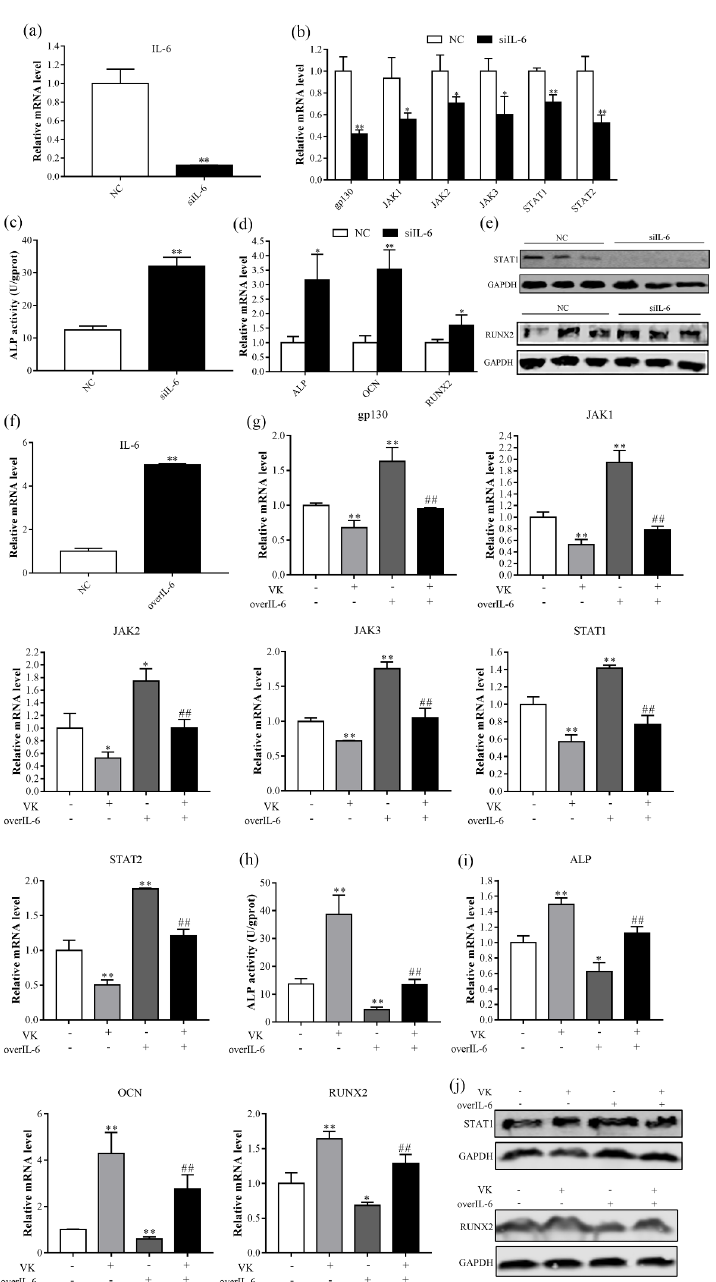
Figure 6. VK 2 promoted osteogenesis by inhibiting STAT1 via IL-6 in C3H10 T1/2 clone 8 cells. ( a ) Knockdown efficiency of IL-6. ( b , d ) The mRNA levels of gp130, JAK1, JAK2, JAK3, STAT1, STAT2 ( b ), and ALP, OCN, and RUNX2 ( d ) after IL-6 knockdown. ( c ) ALP activity after IL-6 knockdown. ( e ) The protein levels of RUNX2 and STAT1 after IL-6 knockdown. ( f ) IL-6 overexpression efficiency. ( g , i ) The mRNA levels of gp130, JAK1, JAK2, JAK3, STAT1, STAT2 ( g ), and ALP, OCN, and RUNX2 ( i ) after IL-6 overexpression during VK 2 induced osteoblastic differentiation. ( h ) ALP activity